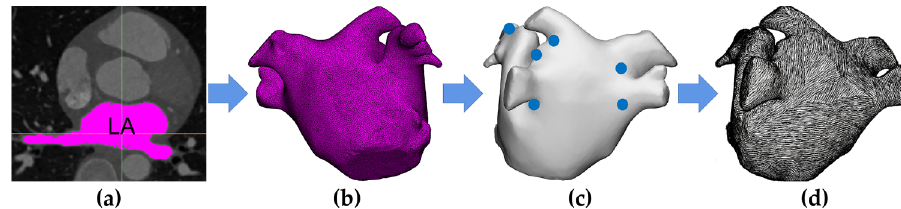
Figure 1. A flow chart of the processes of constructing an anatomy-based model of the left atrium (LA) incorporating fiber orientation. ( a ) Segment LA region from coronary computed tomography angiography (CTA) images; ( b ) generate the triangular and tetrahedral meshes of LA model; ( c ) man- ually mark seeds on the LA model to incorporate fiber orientation into the LA model; ( d ) LA model incorporating fiber